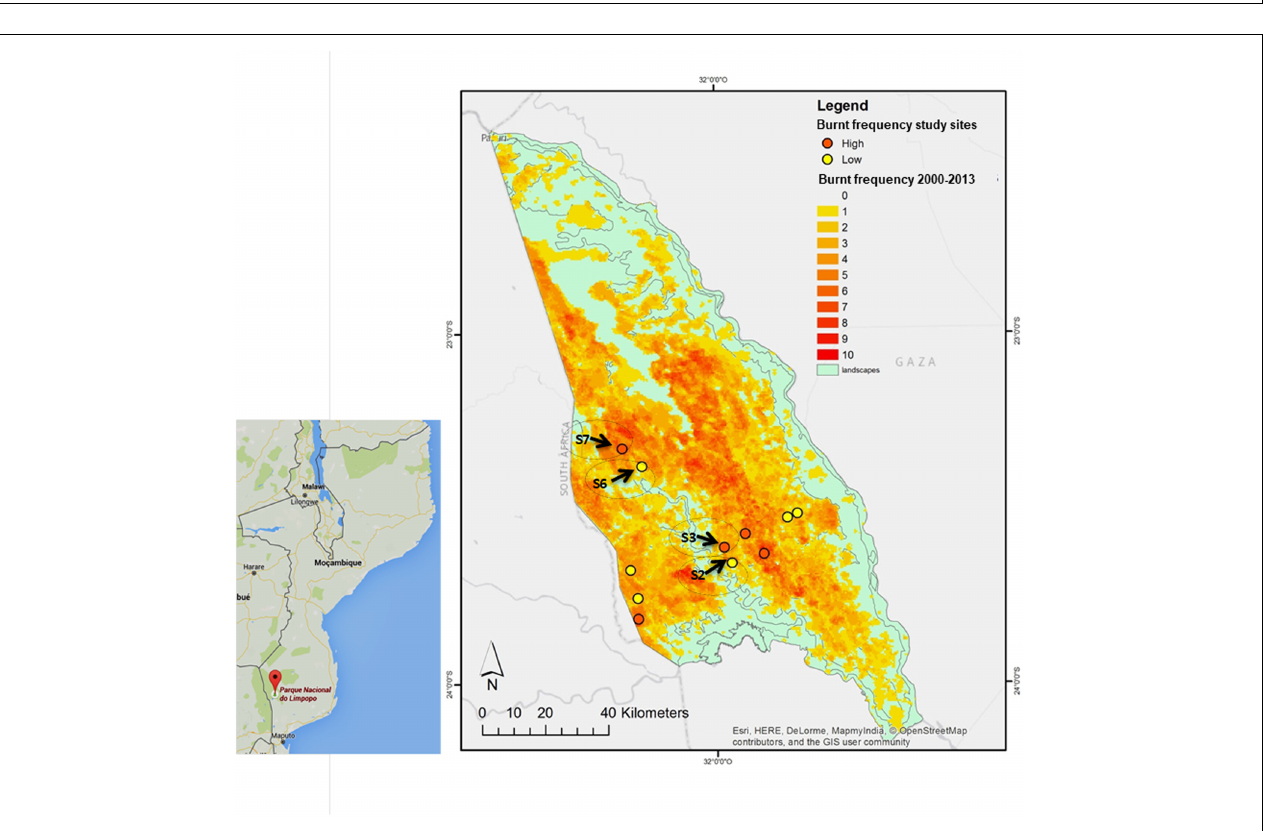
FIGURE 2 | Limpopo National Reserve (LNR) fire areas map: S2, S6 (LFF) S3, S7 (HFF) corresponds to C. mopane sampling areas (Navashni et al., 2015).